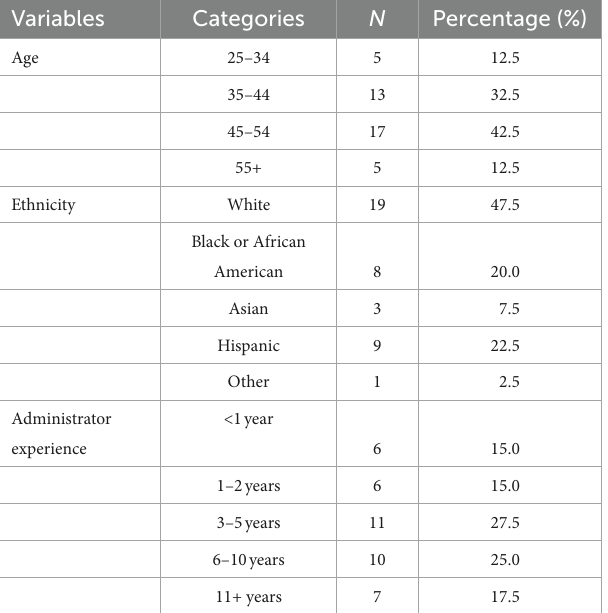
TABLE 1 Principals’ demographic